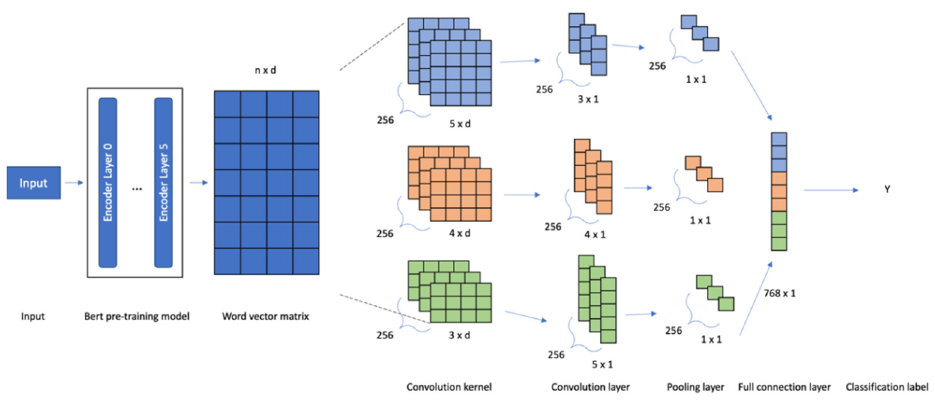
Figure 11. Schematic diagram of the BERT-TextCNN classification process.